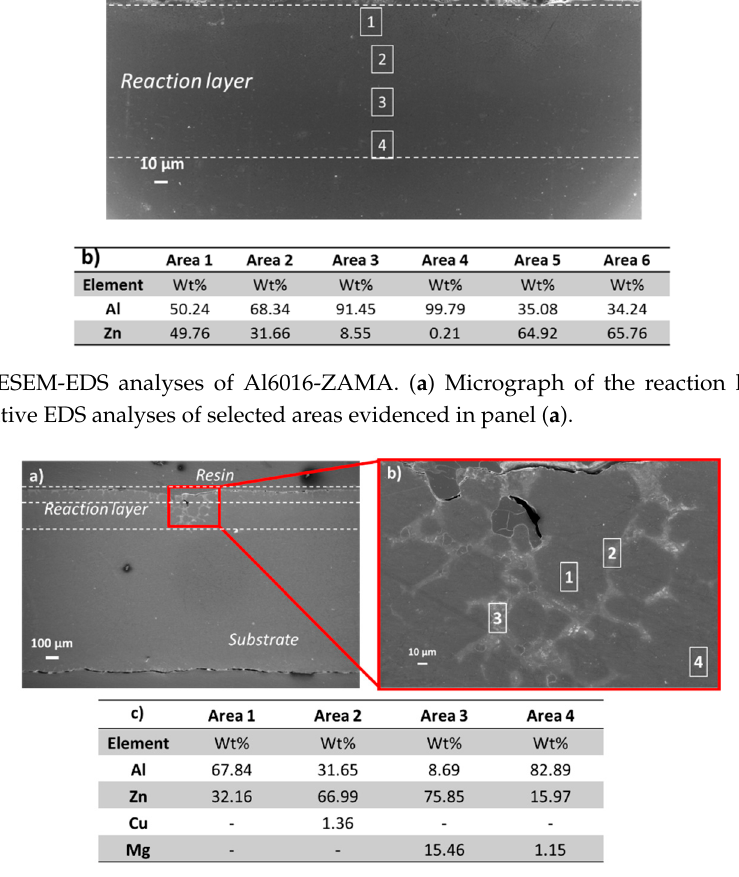
Figure 9. FESEM-EDS analyses of Al5182-ZAMA. ( a ) Low magnification micrograph of transverse section reaction / layer substrate interface; ( b ) high magnification of the reaction zone; and ( c ) semiquantitative EDS analyses of selected areas evidenced in panel ( b ).